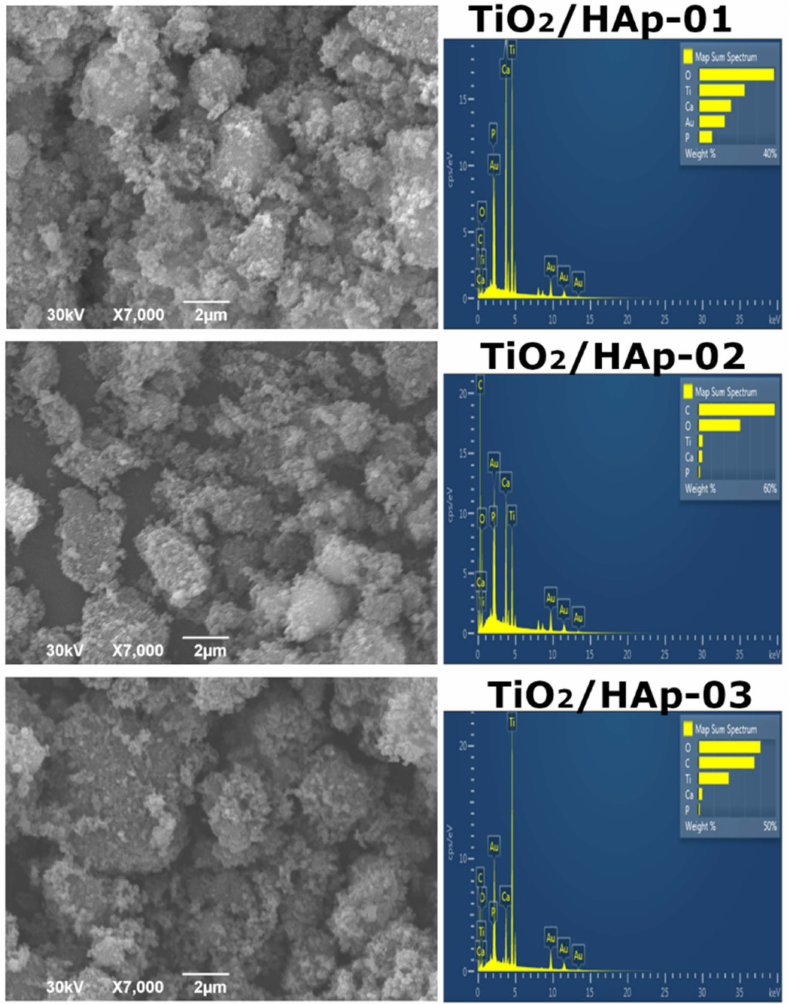
Figure 4. SEM results with inserted EDS spectra TiO 2 /HAp-01, TiO 2 /HAp-02, and TiO 2 /HAp-03. Considering that the SEM images indicated the nanodimensions of the obtained powders, a further investigation of the morphology was needed. The TEM images of all prepared samples were taken in that respect, and the obtained results were presented in Figure 5.